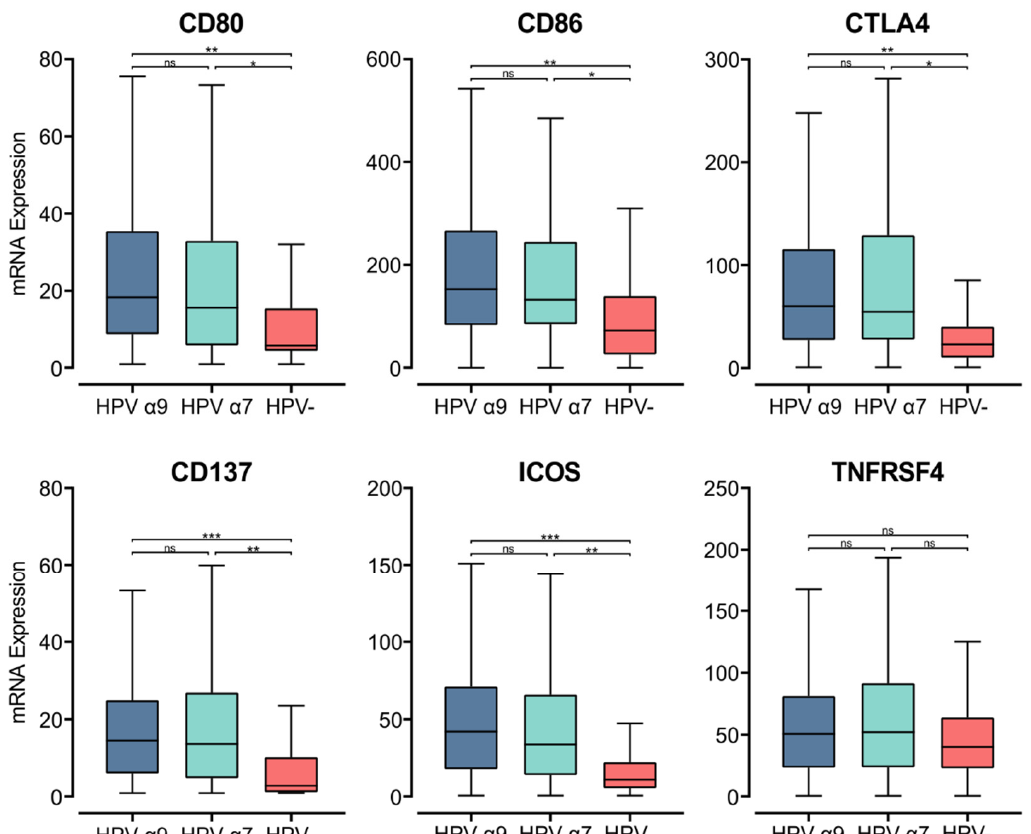
Figure 4. Expression of genes that encode for T cell co-stimulatory and activation molecules in CC stratified by HPV+ ( α 9 or α 7) and HPV − status. Normalized RNA-seq data for genes encoding important costimulatory molecules and T cell activation markers were extracted from the CC cohort of the TCGA database. *** p ≤ 0.001, ** p ≤ 0.01, * p ≤ 0.05, ns (not significant).